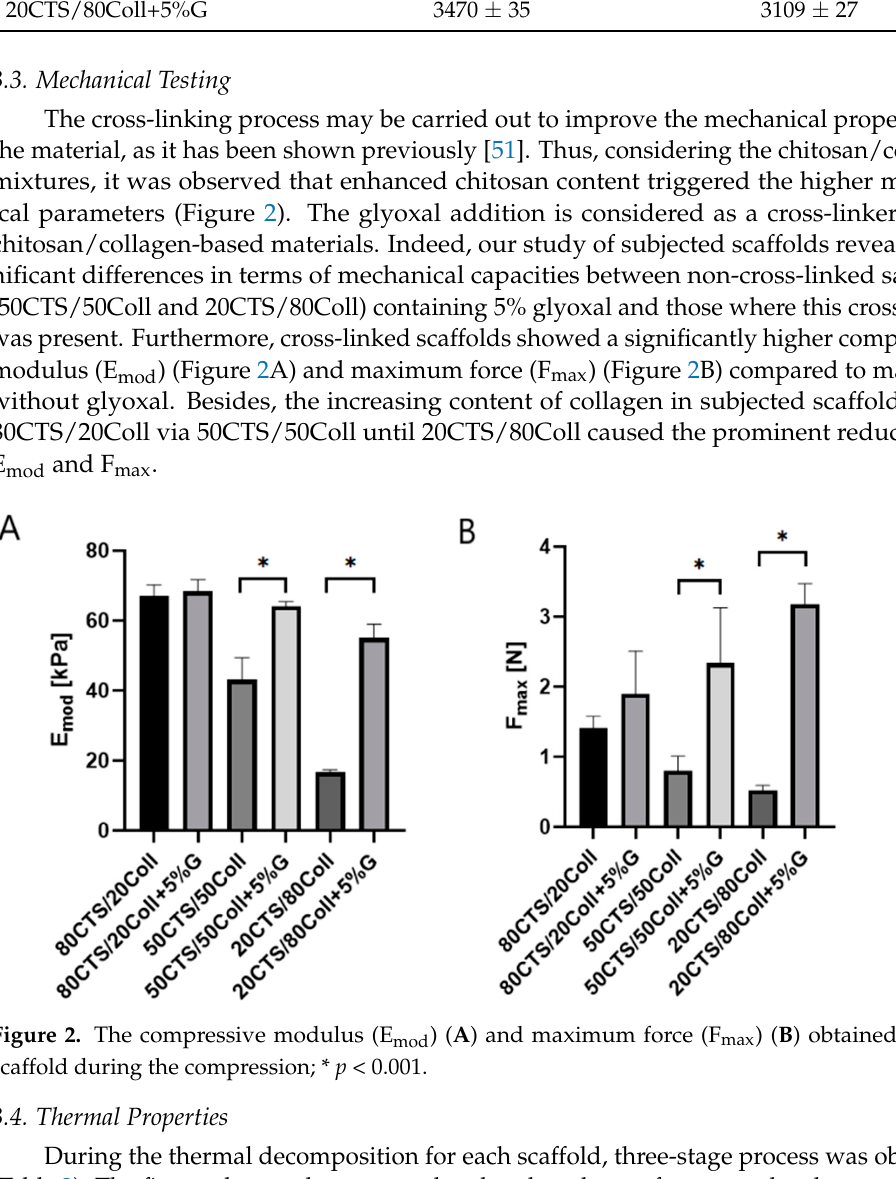
Table 1. The weight change of scaffold after 1 h and 24 h immersion in PBS.